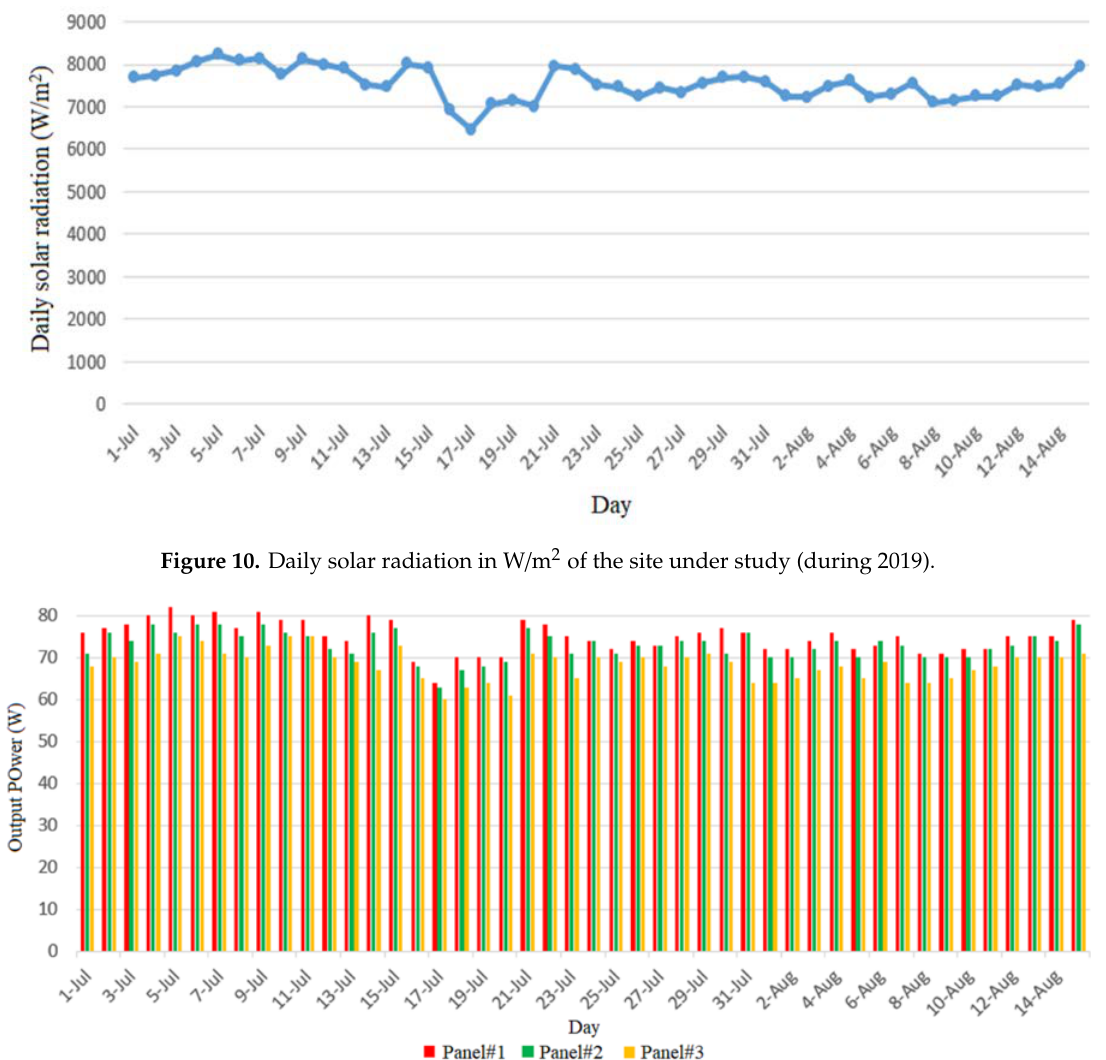
Figure 10. Daily solar radiation in W/m 2 of the site under study (during 2019).